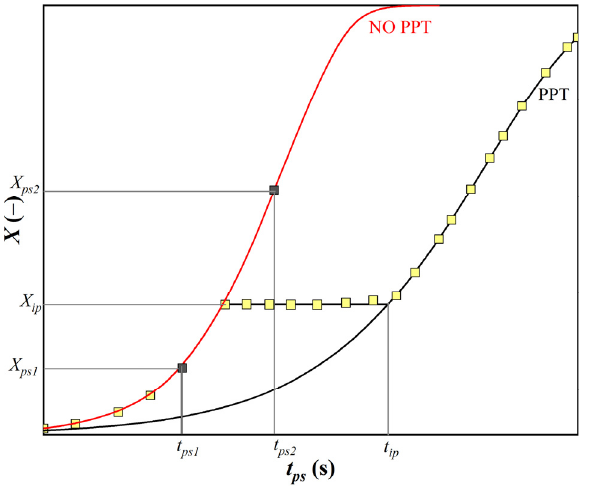
Figure 9. Possible situations that may occur in the collection in which the conditions for the start of SIP are met.